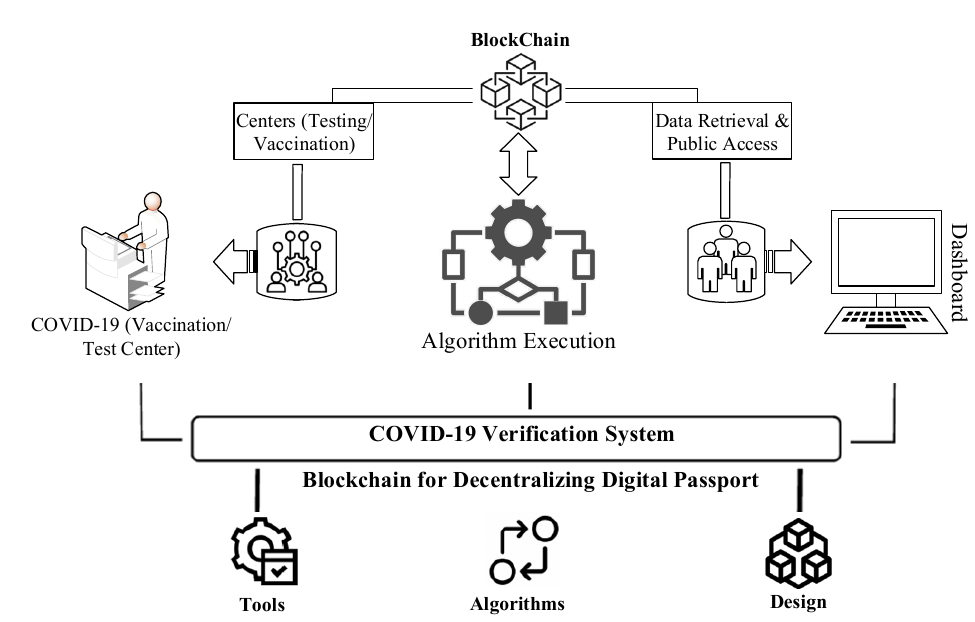
Figure 1. A high ‐ level overview of the suggested Model. Figure 1. A high-level overview of the suggested